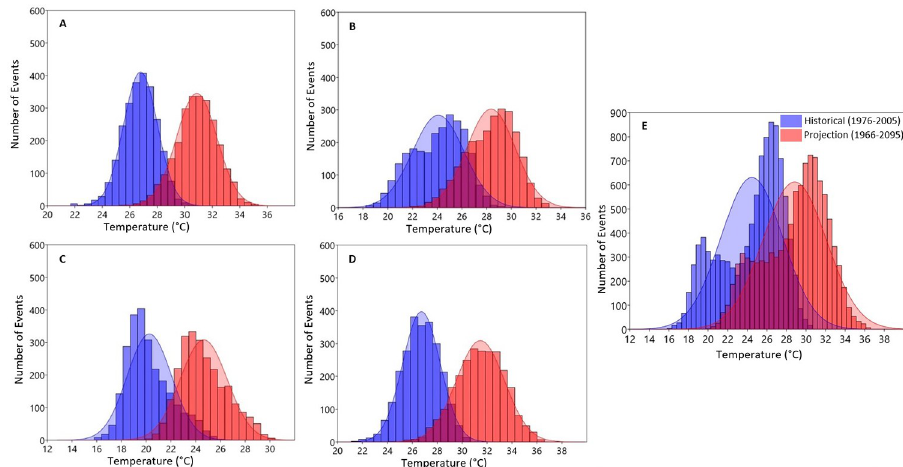
Fig 8. Probability distribution estimation of daily seasonal A) Summer, B) Autumn, C) Winter, D) Spring and E) annual maximum temperatures Over Olifants Catchment (1976–2005 vs. 2066–2095).